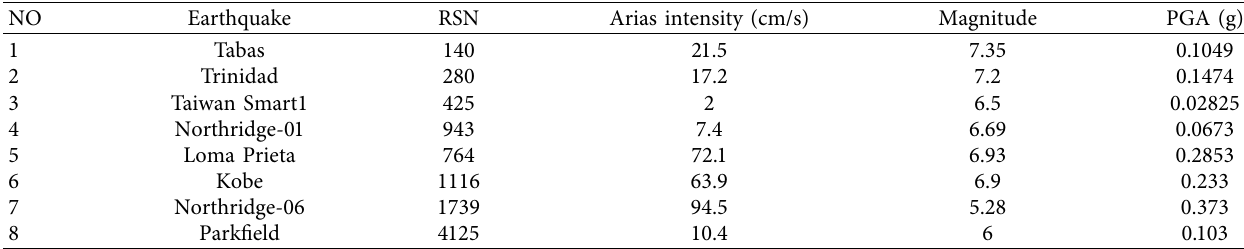
Table 13: Seismic MS and AS records (near-feld and far-feld) (SS).